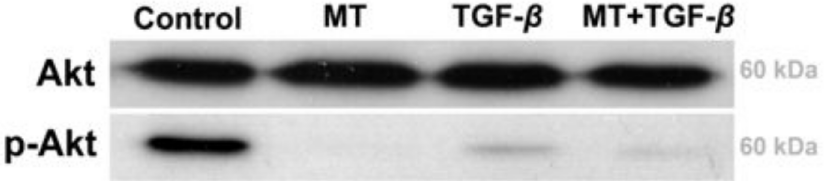
Fig 8. PI3K/Akt pathway analysis. PI3K/Akt pathway activation was assessed by Western blotting for Akt and phospho-Akt in T24 cell lysates. After 48 hours of incubation with MT, TGF- β , and MT + TGF- β , a decreased level of phospho-Akt was observed. Inhibition of the PI3K/Akt pathway is associated with EMT in T24